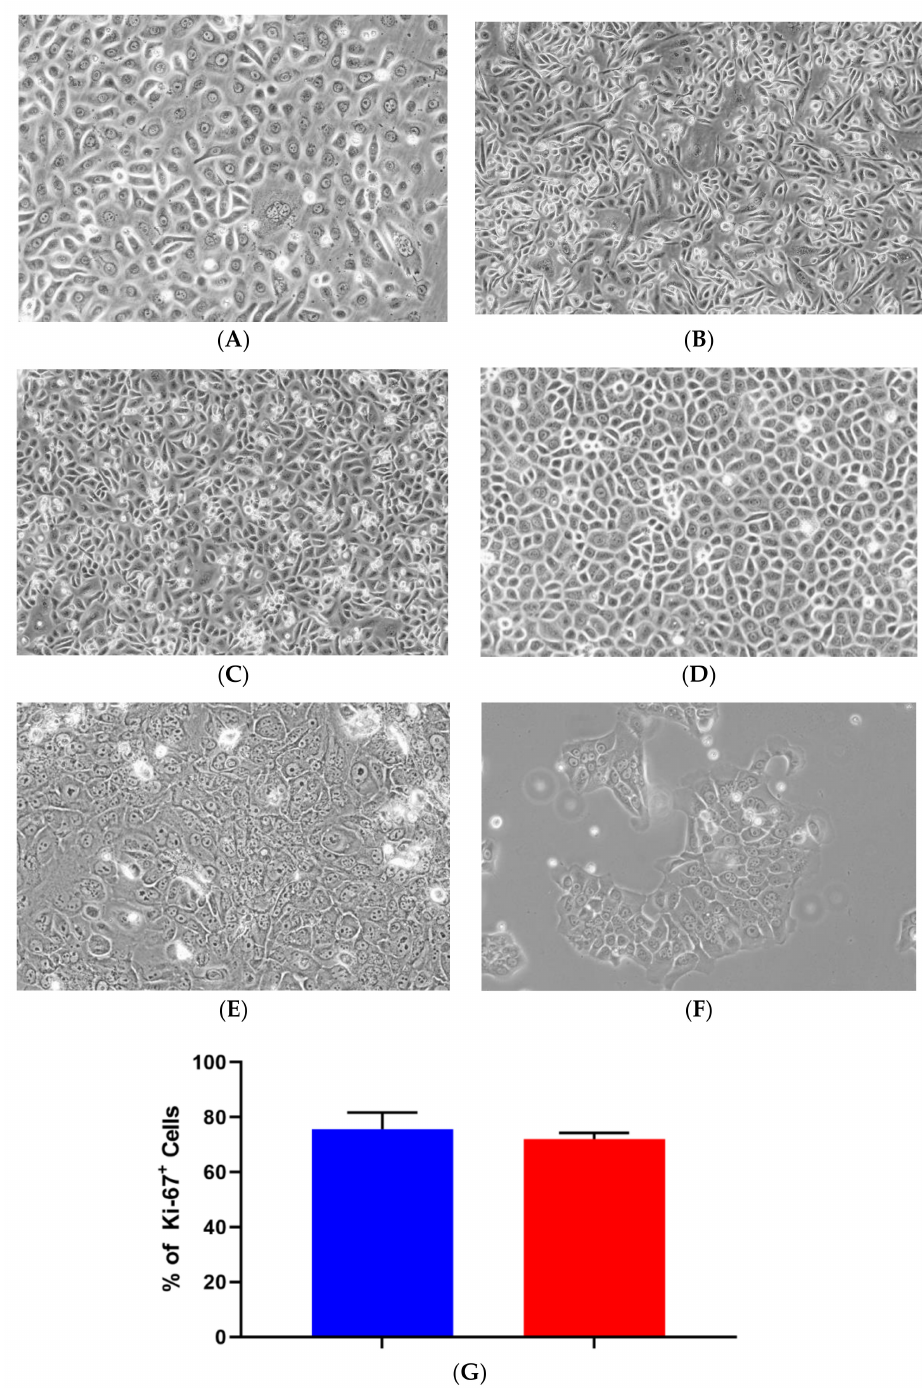
Figure 1. Morphology and proliferation of iSGECs. Legend. Representative images of early passage (p-14) monolayer culture ( A ) iSGEC-pSS1 ( B ) iSGEC-nSS1 ( C ) iSGEC-nSS2 and ( D ) late (p-80) iSGEC-nSS2. iSGEC-nSS2 “cobblestone-like” morphology was maintained across multiple passages when grown in SGEC sub-culturing media with low (0.06 mM) Ca 2 + . Cell morphology changes in ( E ) iSGEC-nSS2 p-14 and ( F ) iSGEC-nSS2 p-80 are observed when medium is supplemented with 1.2 mM Ca 2 + (final concentration) for 72 h. ( G ) Proliferation of iSGEC-nSS2 was assessed by the percentage (%) of Ki-67 + cells using immunocytochemistry. No significant di ff erence in the percentage of Ki-67 + cells was detected between early (p-14) and late (p-80) iSGEC-nSS2 cultures. Student’s t -test (* p < 0.05, NS = not significant). Data are means +/ − SEM. Magnification × 20, scale bar = 200 µ